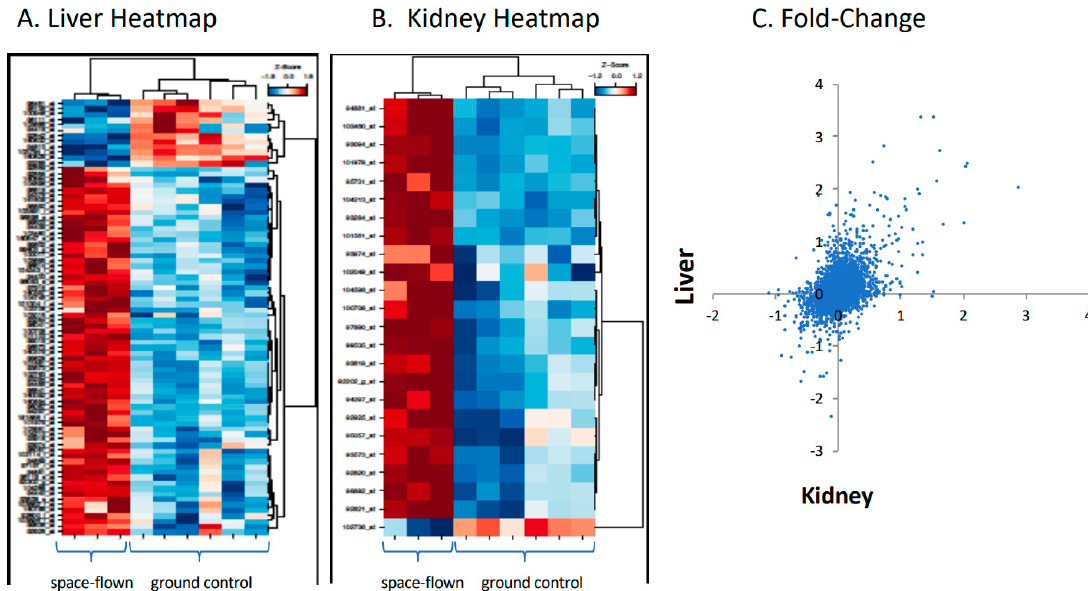
Figure 1. Gene expression for mouse liver and kidney flown in space versus ground controls. Responses of 12,489 genes in mouse liver and kidney, flown in space versus ground controls, as analyzed by Affymetrix hybridization. Panel ( A ) is the heat map of representative liver samples. Panel ( B ) is the heat map for representative kidney samples. Panel ( C ) is the fold-change in gene expression for liver ( y -axis) plotted against kidney ( x -axis).